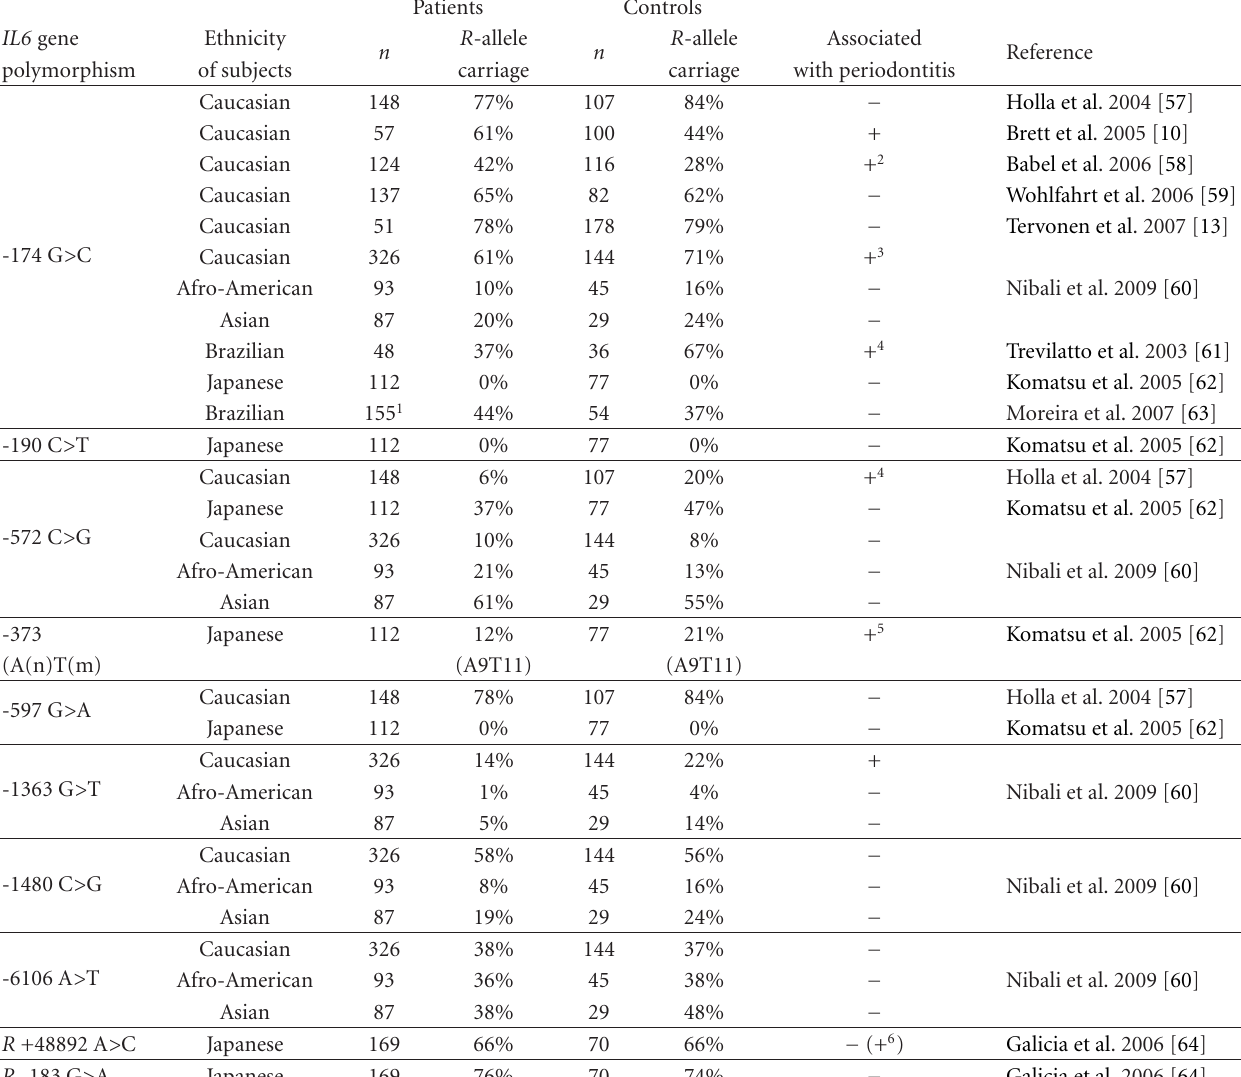
Table 7: IL6 and IL6R gene polymorphisms and carriage of the Rare ( R )-allele in case-control studies and association with susceptibility to chronic